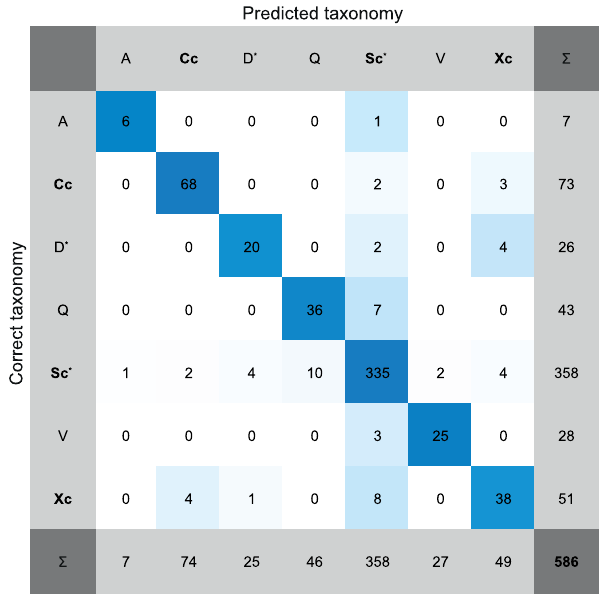
Frontiers in Astronomy and Space Sciences |